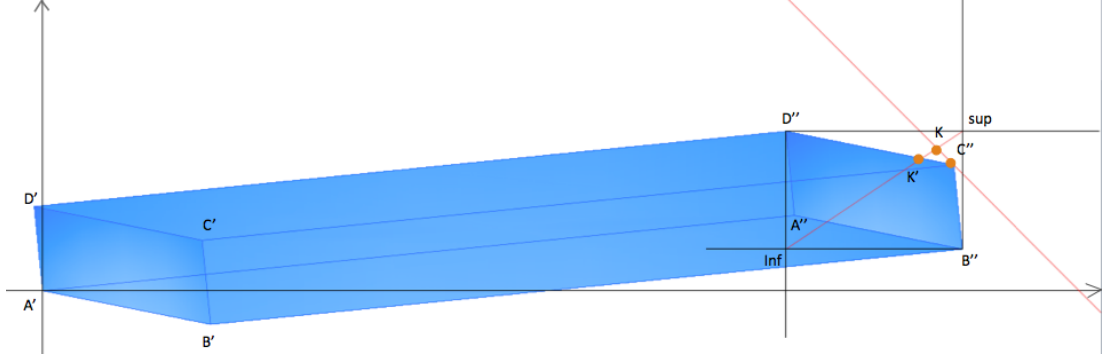
Figure 4. Coopetitive solutions: K′ (best compromise solution); C″ (purely coopetitive solution); K (transferable utility Kalai–Smorodinsky solution).